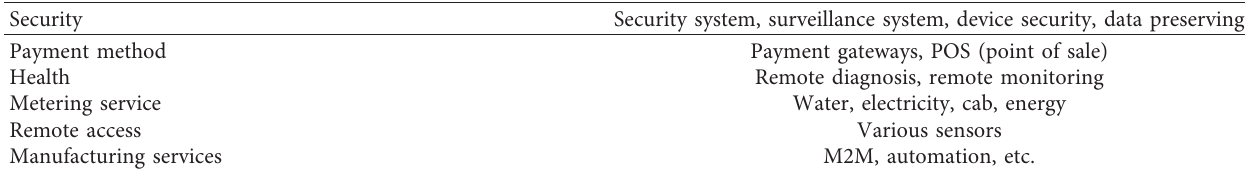
Table 6: Application areas of IoT.